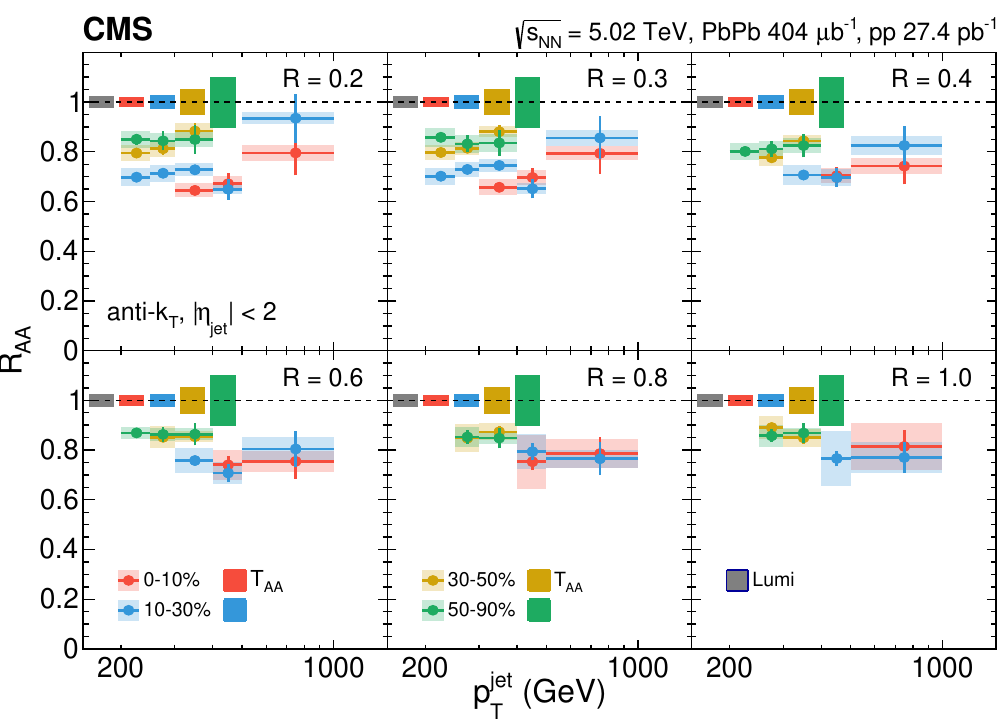
for jets with | η jet | < 2 . 0 as functions of p jet for various R and centrality classes. Figure 7 . The R AA T The statistical uncertainties are represented by vertical lines, and the systematic uncertainties by shaded boxes. The markers are placed at the bin centers. Global uncertainties (integrated luminosity for pp and h T i for PbPb data) are shown as colored boxes on the dashed line at AA = 1 and are not included in the shaded boxes around the R AA